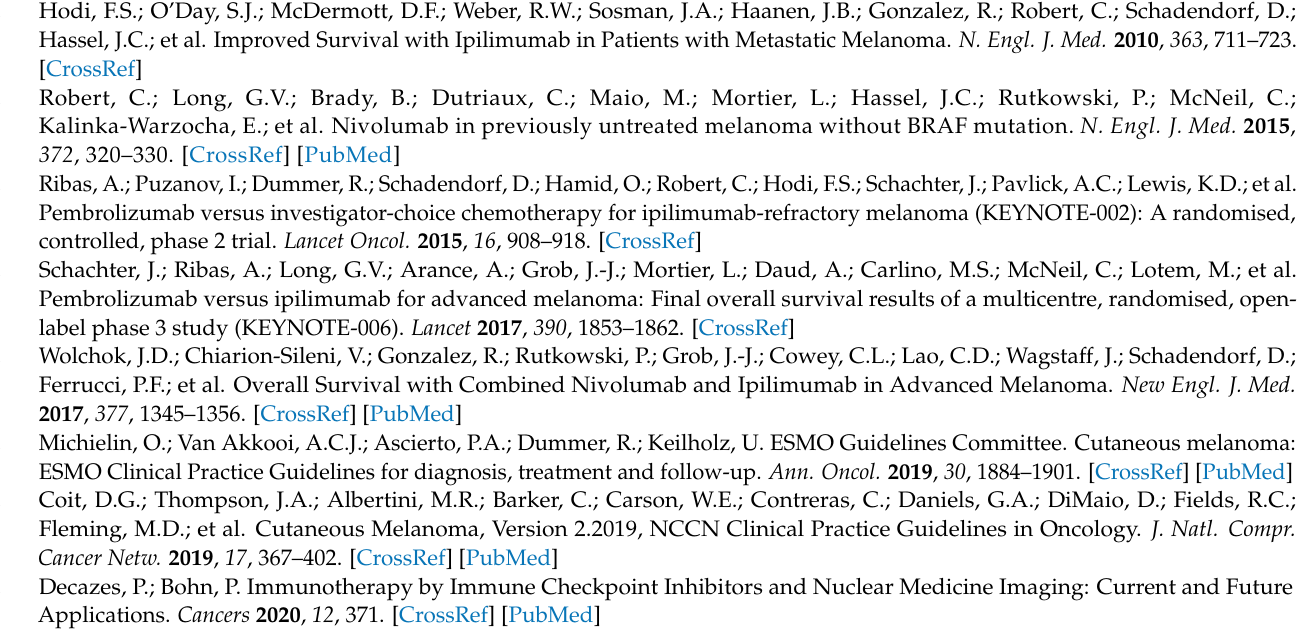
F-FDG semi-quantitative and quantitative parameters before and after two cycles of combination therapy. Table S3: Median values of the 18 F-FDG semi-quantitative and quantitative parameters before and after two cycles of anti-PD-1 therapy, derived from melanoma lesions classified according to their